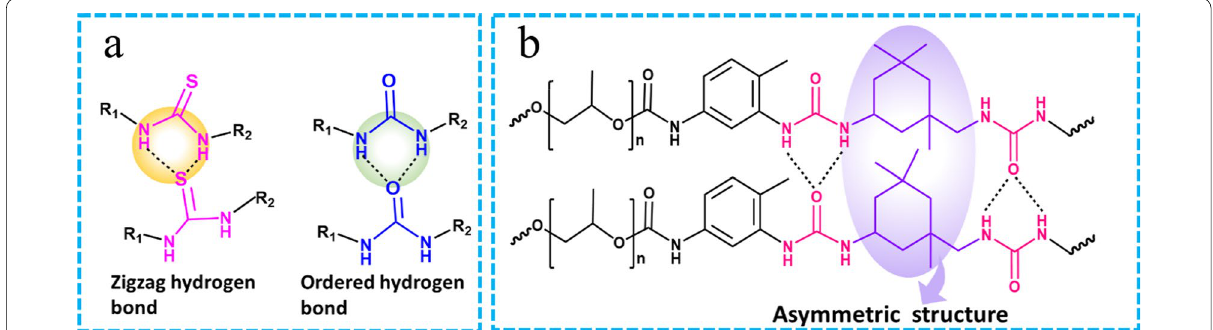
Fig. 8 a Types of hydrogen bonds formed by thiourea and urea groups. b Schematic illustration of the asymmetric macrocyclic structure hindering the regular arrangement of urea hydrogen